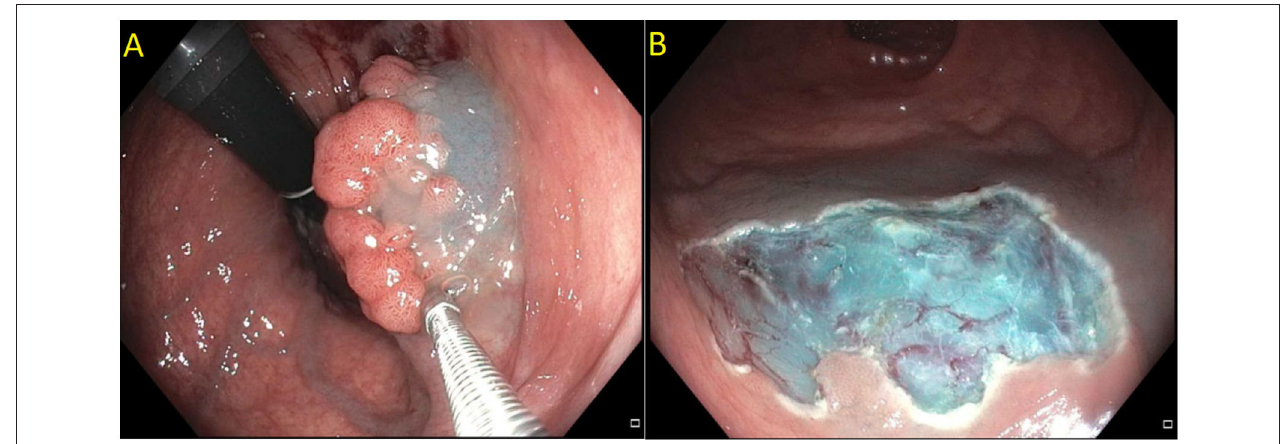
FIGURE 8 | (A) Submucosal injection using ORISE TM gel submucosal lifting agent (Boston Scientific). (B) Submucosa easily identify with indigocarmine non-vital